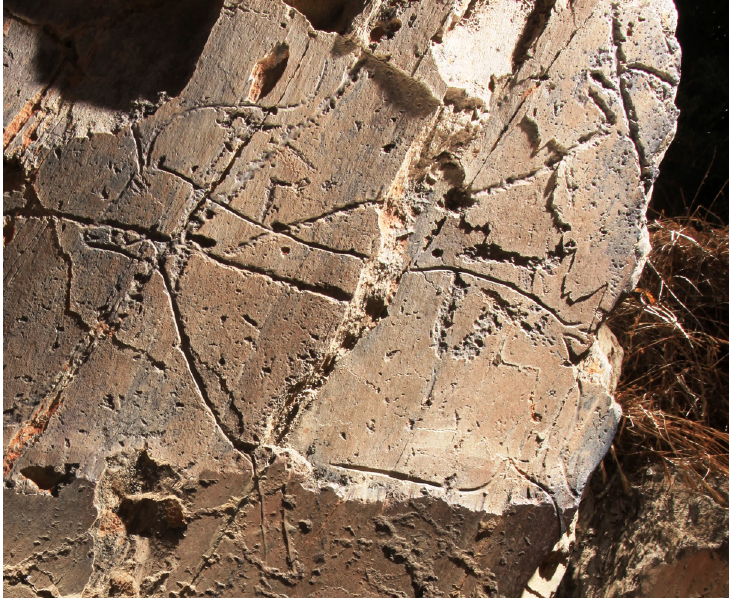
Figure 15. Two-headed goat motif in Penascosa Rock 5. Note also the three-lines tail. Photo: Mário